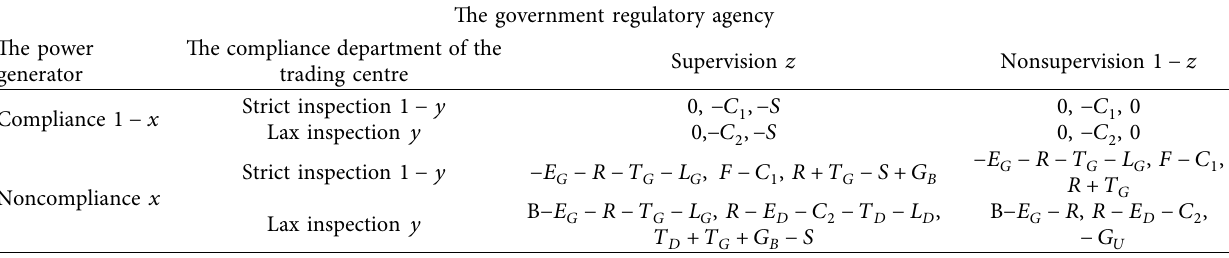
Table 2: Payoff matrix of the